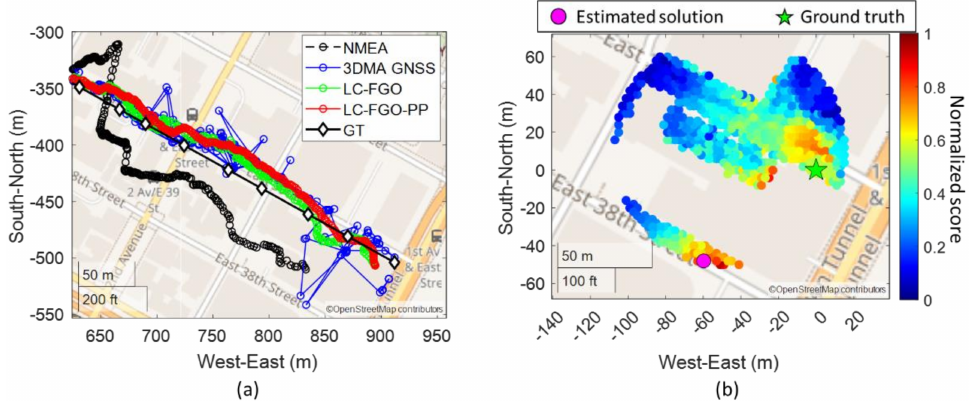
Figure 8. ( a ) zoom − in map plot near the end of Trip 2. ( b ) one of the epochs with large position error due to local minima